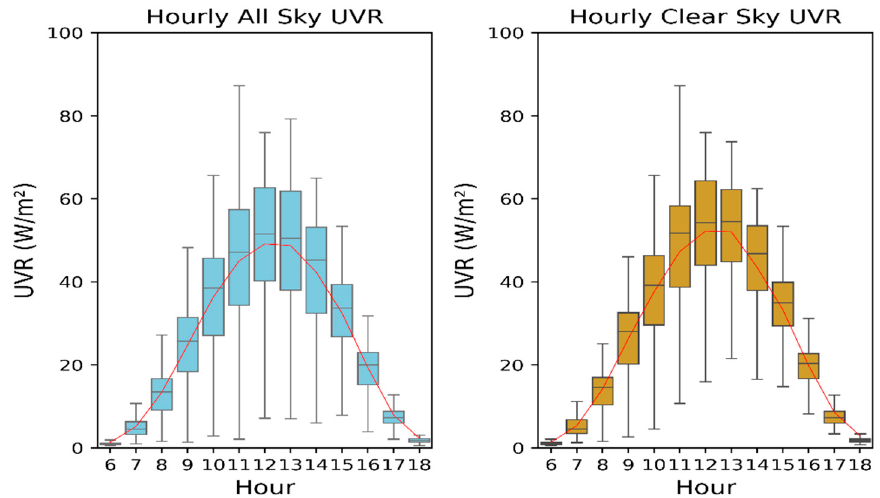
Figure 5. UVR hour-daily series in all sky and in clear sky conditions.